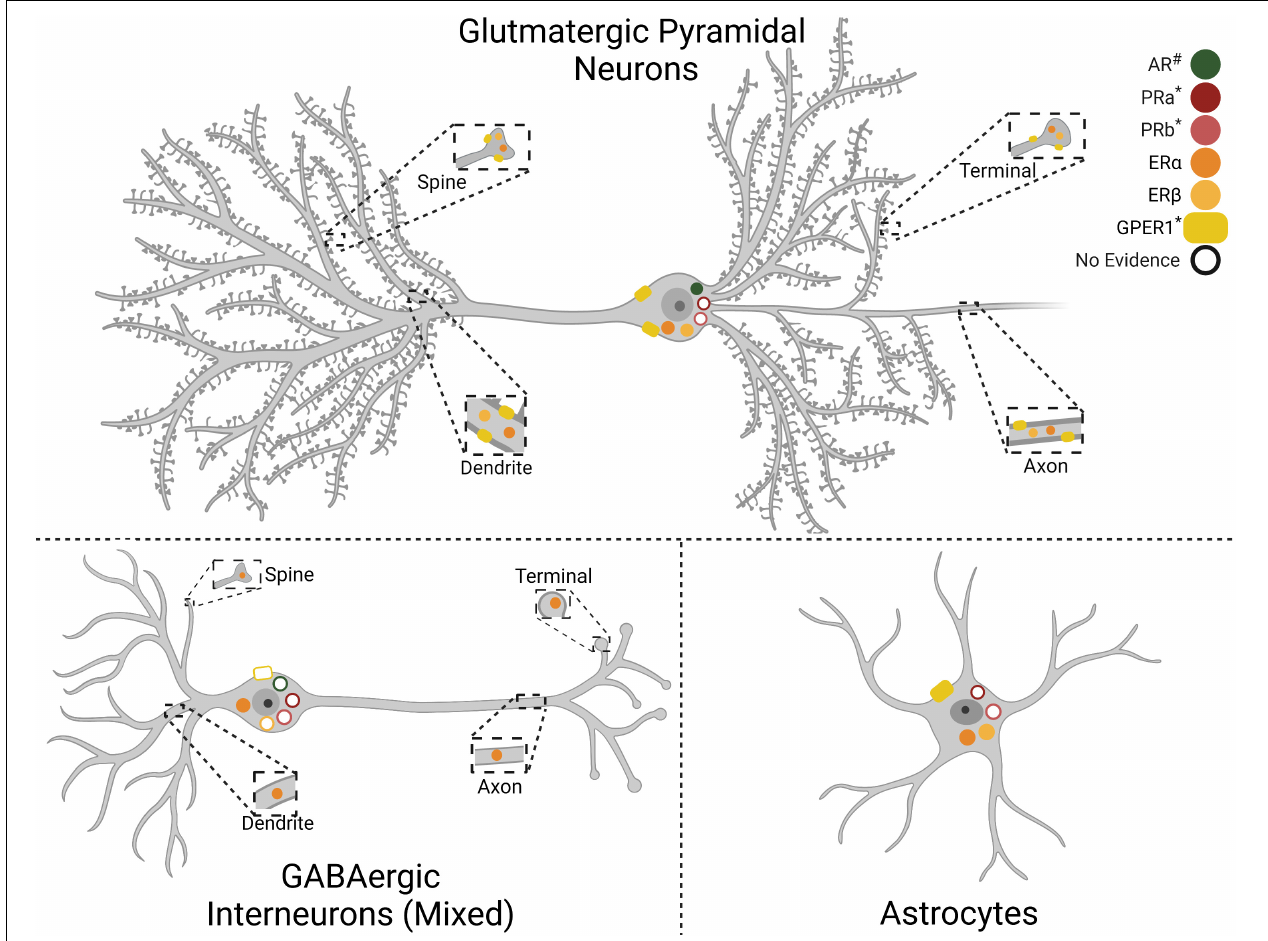
FIGURE 1 | Gonadal hormone receptor expression in infralimbic cortex (IL) cell types. Depiction of gonadal hormone receptor expression and localization. Filled symbols indicate evidence for expression in the cell type and cellular compartment. Empty symbols denote lack of information as to the presence or absence of the receptor. Progesterone receptor cell-type specifity has not been reported. Androgen Receptor (AR), Progesterone Receptor A (PRa), Progesterone Receptor B (PRb), Estrogen Receptor α (ER α ), Estrogen Receptor β (ER β ), G protein-coupled estrogen receptor 1 (GPER1). #AR expression is higher in males than females. *PRa, PRb, and GPER1 expression has only been reported in females. Created with